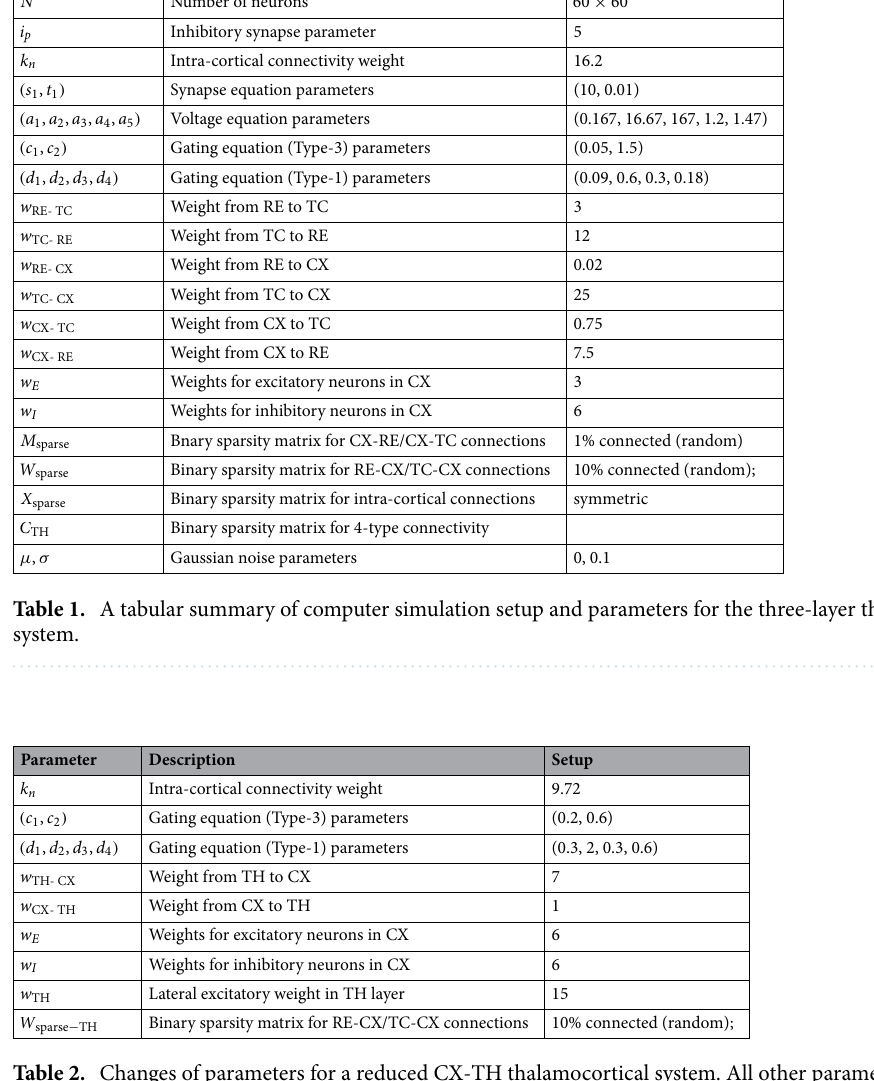
Table 2. Changes of parameters for a reduced CX-TH thalamocortical system. All other parameters remain the same as in Table 1. All parameters for the TC layer are